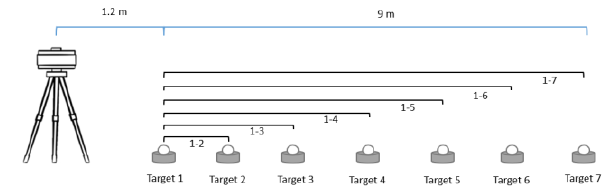
Figure 5: Scanning set up to test automatic extraction and quality of sphere fit